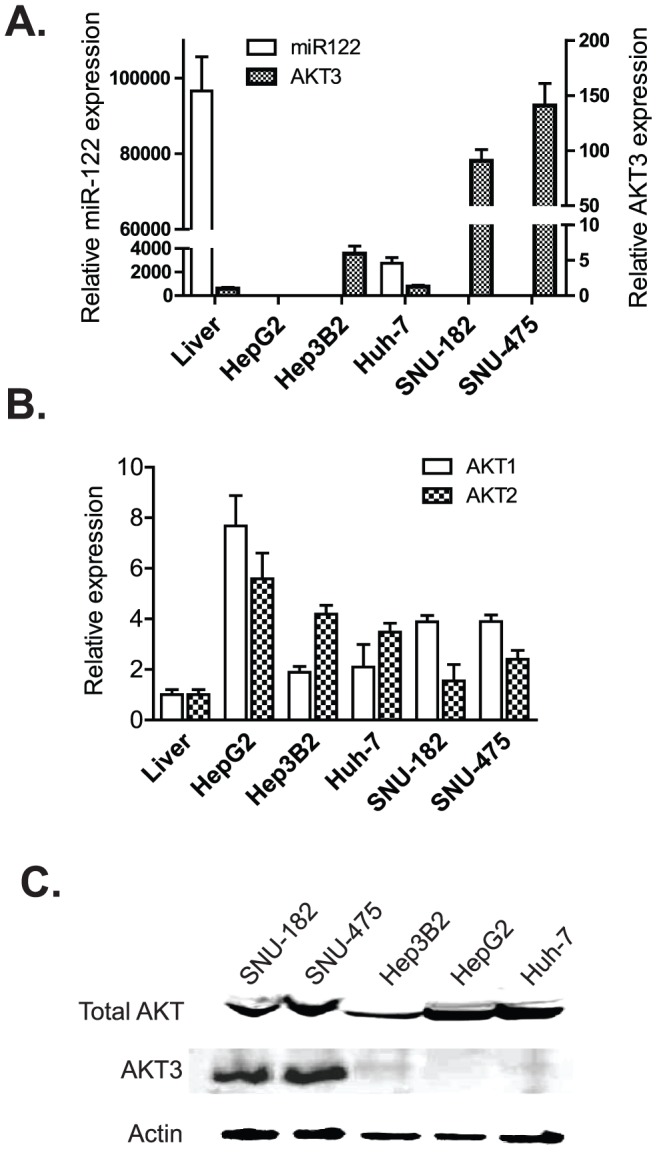
AKT3 expression is inversely correlated to miR-122 levels in HCC cell lines.(A) The AKT3 transcript level normalized to its expression in normal liver (right Y axis) and normalized miR-122 expression (left Y axis) were measured in various HCC cell lines. (B) The relative expression level of closely homologous isoforms AKT1 and AKT2 were measured in HCC cell lines. (C) Western blot analysis of total AKT and AKT3 protein levels in various HCC cell lines. Actin was used as the loading control in these studies.